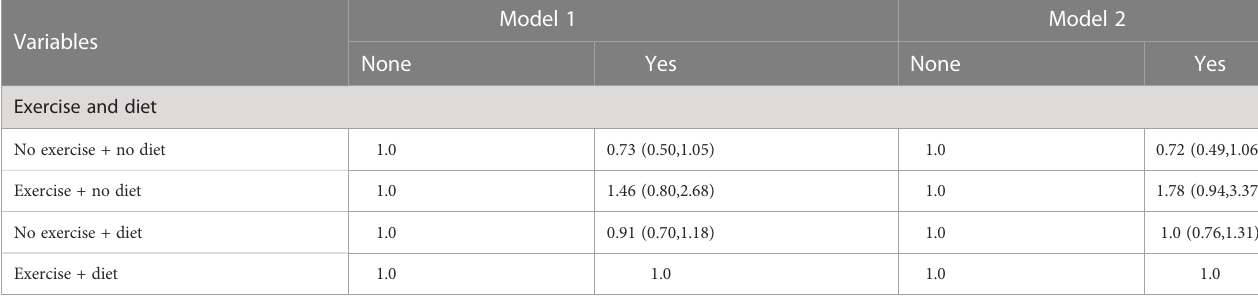
TABLE 15 The correlation between intervene and CVD.